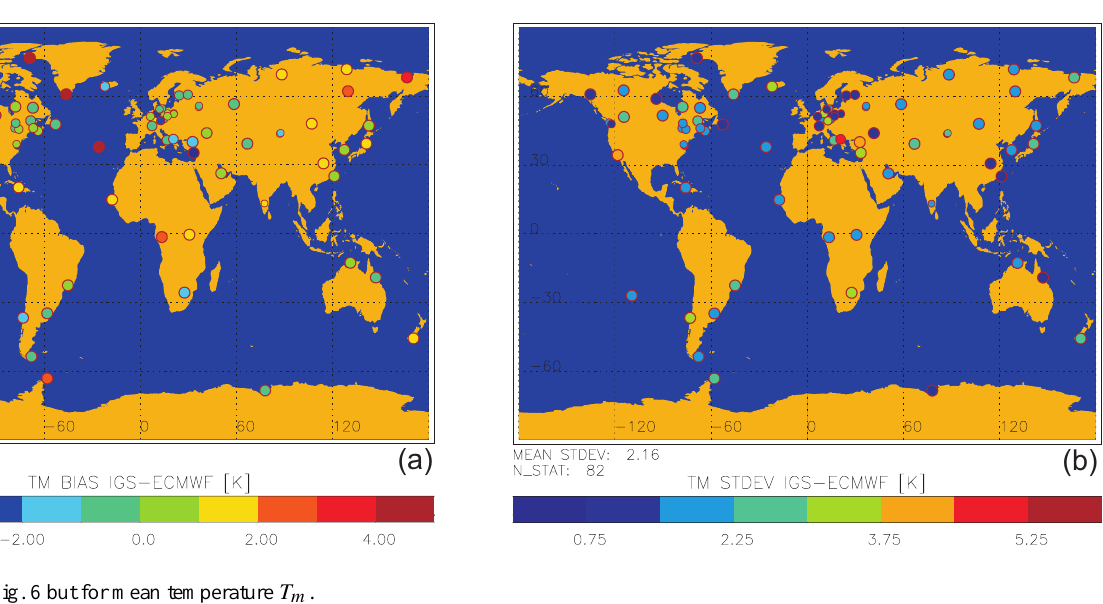
Fig. 6. Comparison of 2007 P s data from ECMWF and station sensors at 03:00, 09:00, 15:00, 21:00UT: (a) bias, (b) standard deviation.